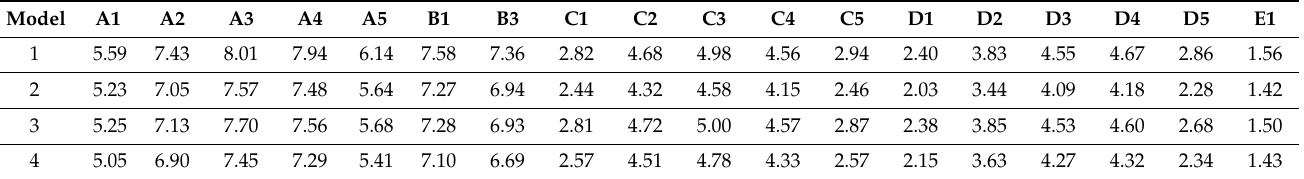
Table 4. Results, average value, and sum of displacements in the Z direction at characteristic measurement points, obtained in the numerical simulation of the welding process of the furnace wall